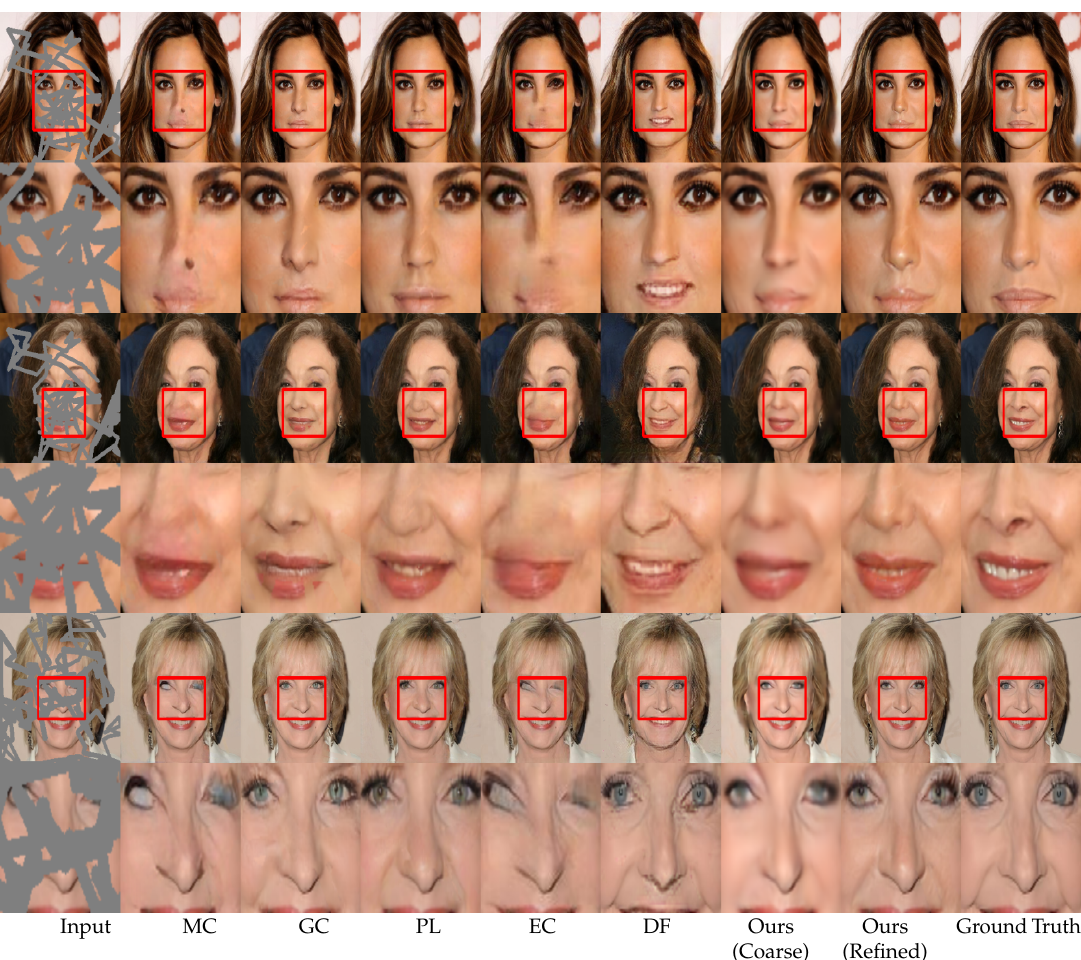
Figure 8. Qualitative comparison on CelebA-HQ [23] dataset. From the left: input, MC [18], GC [16], PL [39], EC [19], DF [40], proposed method (coarse output), proposed method (refined output), and the ground